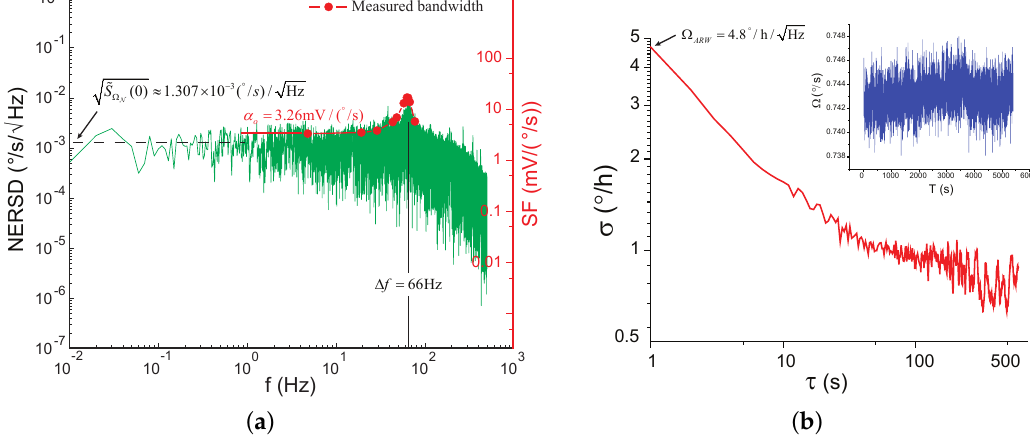
Figure 16. The NER spectral density of the gyroscope in the open-loop mode-split case. ( a ) The NER spectral density and the measured frequency response of the gyroscope; ( b ) The Allan Variance of the gyroscope output.(Insert: the time series of the recorded